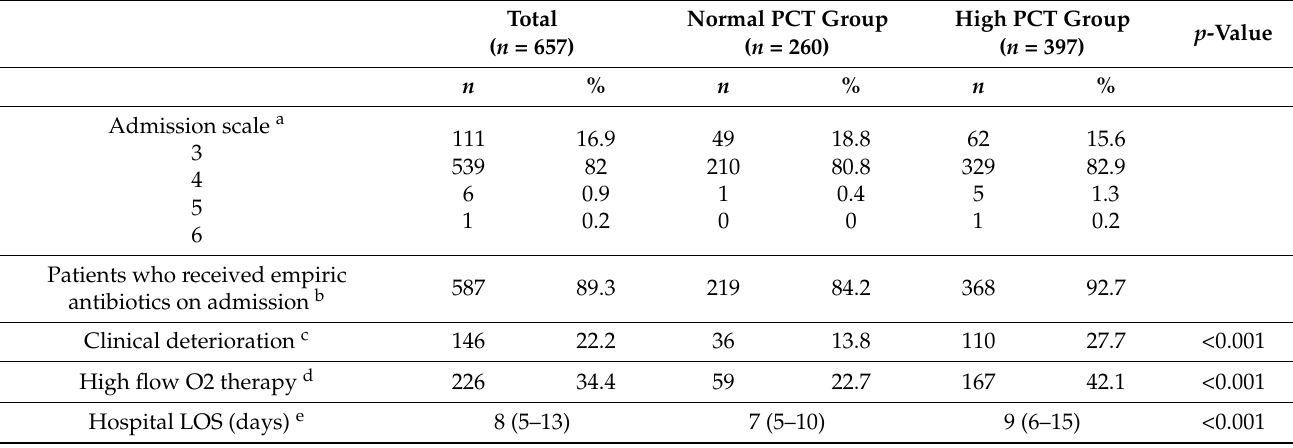
Table 2. The hospital course of the normal and the high PCT